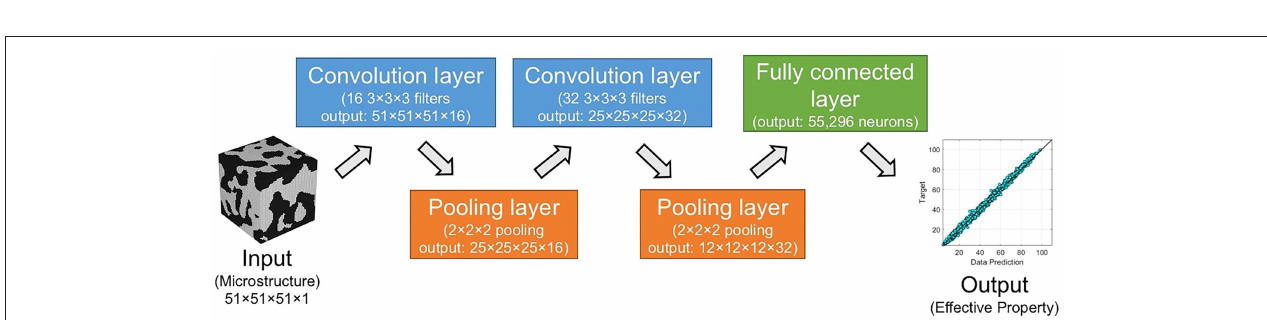
FIGURE 11 | Schematic image of the three-dimensional convolutional neural network (CNN) architecture, containing a convolutional layer for feature extraction, a pooling layer for dimensionality reduction of feature maps, as well as a fully connected layer and a single-noded output layer, yielding the desired material property. Reprinted from Yang et al. (2018), Copyright (2018), with permission from